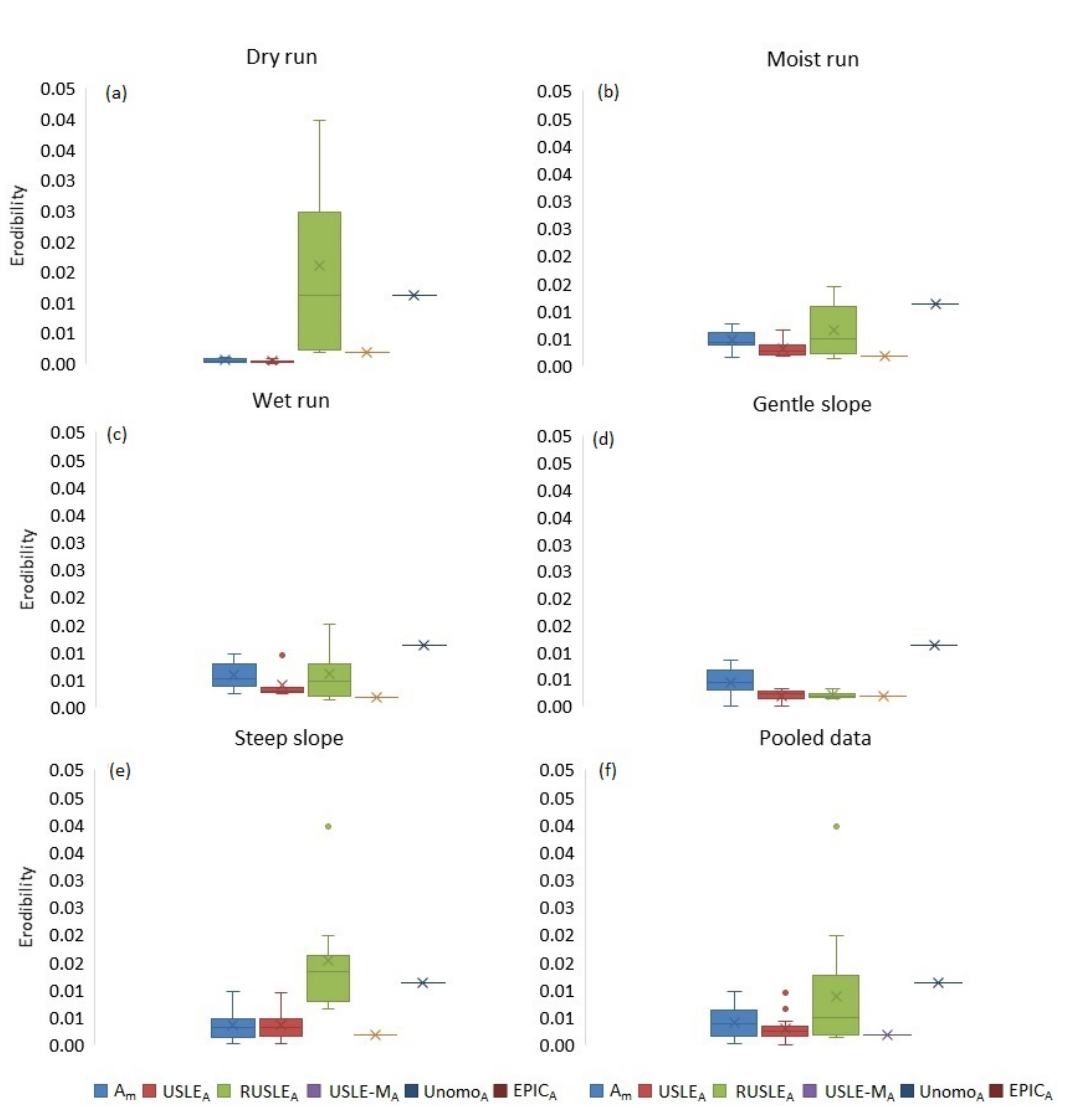
Figure 2. Comparison of calculated erodibility values by USLE, RUSLE and USLE-M (t ha h ha − 1 MJ − 1 mm − 1 ), as well as USLE and EPIC nomograph equations (t ha h ha − 1 MJ − 1 mm − 1 ) according to ( a ) dry runs, ( b ) moist runs, ( c ) wet runs, ( d ) gentle slope, ( e ) steep slope and ( f ) pooled data.